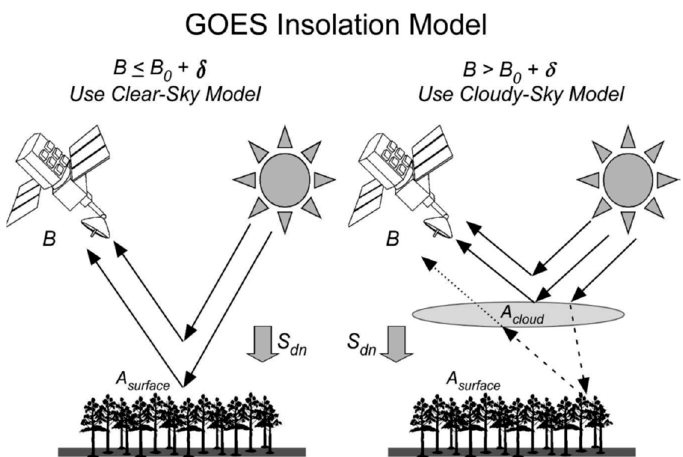
Figure 2. Graphical depiction of the physical model employed for (left-hand side) clear-sky conditions and (right-hand side) cloudy-sky conditions; B refers to the brightness observed by the satellite, while B 0 is the clear-air brightness threshold; Sdn refers to the downward shortwave radiation flux; and A surface and A cloud refer to the surface and cloud albedos, respectively.